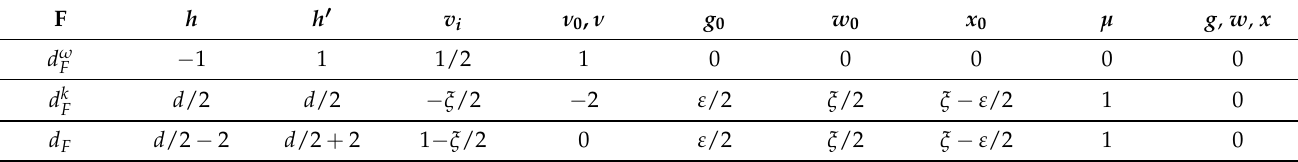
Table 1. Canonical dimensions of the fields and the parameters in the theory (11); ε = 4 − d